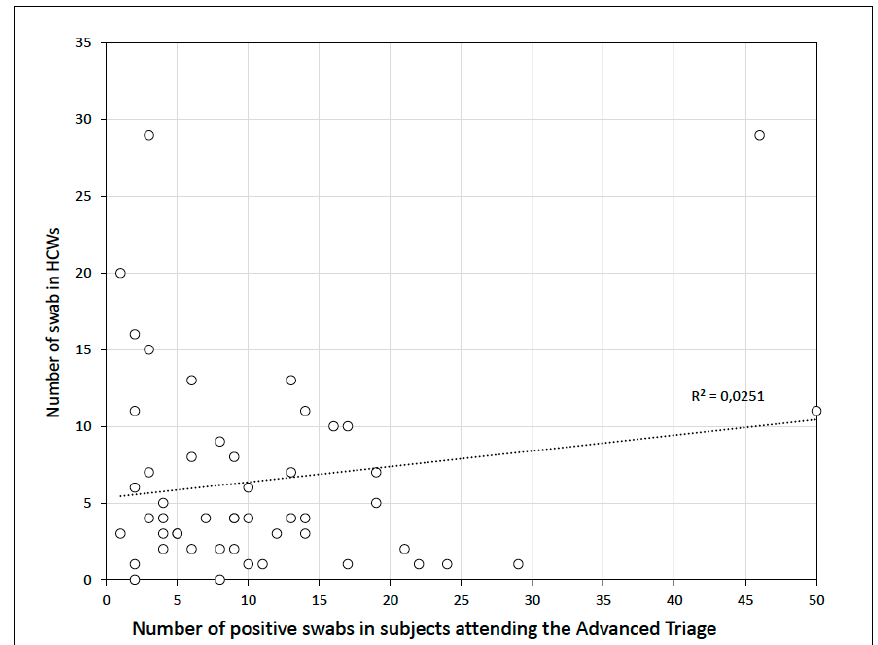
Figure 4. Linear regression analysis between the total positive nasopharyngeal swabs and the number of swabs performed on healthcare workers (HCWs). Each point represents a day of the period study. Finally, the amount of PPE used during the study period is shown in Table 2. Table 2. Nasopharyngeal swabs performed on the healthcare workers and personal protective equipment used during the 8 weeks study period.